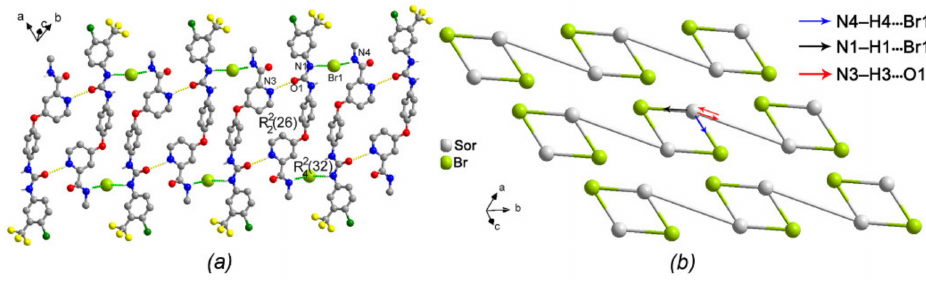
Figure 7. ( a ) Part of the crystal packing of (IV), hydrogen bonds are shown as green and yellow dashed lines, H atoms not involved in hydrogen bond have been omitted for clarity; ( b ) 2,3-Connected dinodal topological net representing the hydrogen bond chain structure of